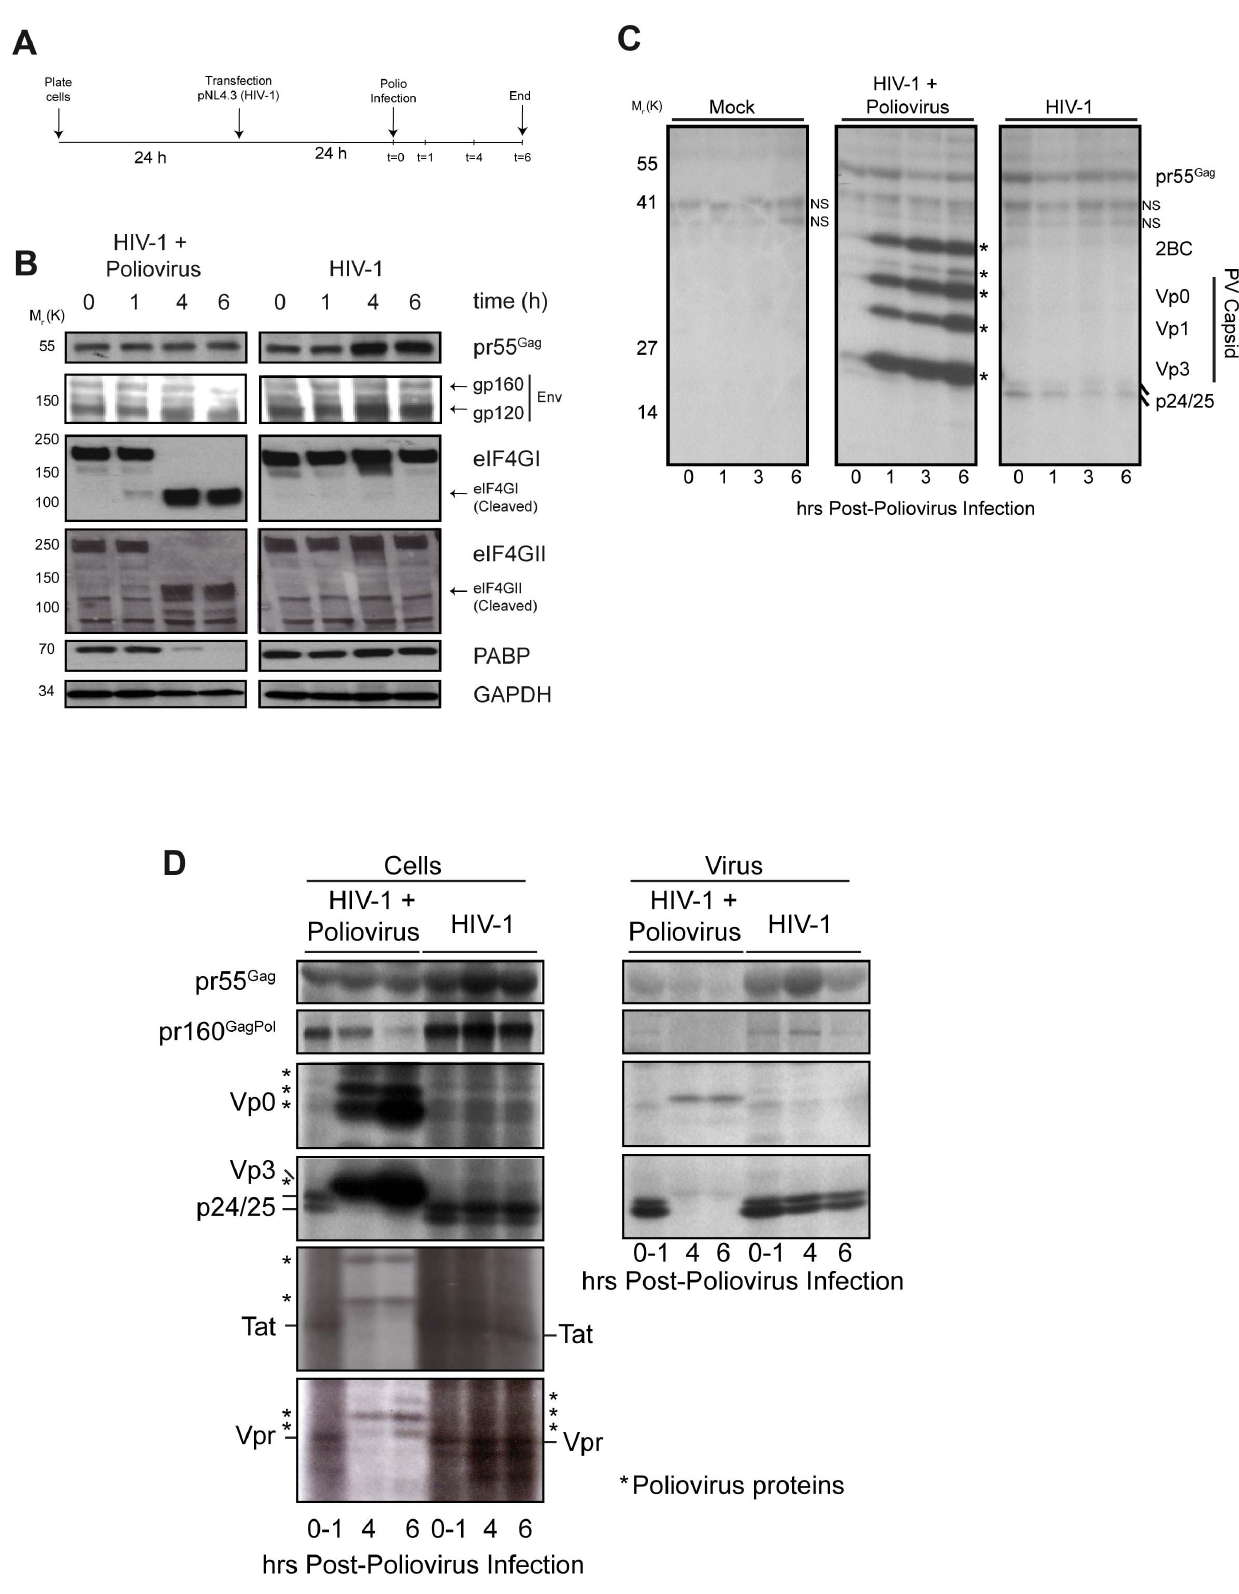
Figure 5. Poliovirus infection does not block HIV-1 pr55 Gag synthesis but dramatically reduces 4kb- and 2kb-encoded viral gene products, Vpr and Tat. (A). Schematic representation of the experimental protocol. (B) Whole cell lysates were analyzed for viral pr55 Gag and gp160/gp120 (Env) and host proteins eIF4GI, eIFGII and PABP by western blotting analyses. GAPDH served as a loading control (bottom). (C,D) At the time points indicated post-infection, cells were briefly pulsed with radiolabelled amino acids and immediately harvested for immunoprecipitation